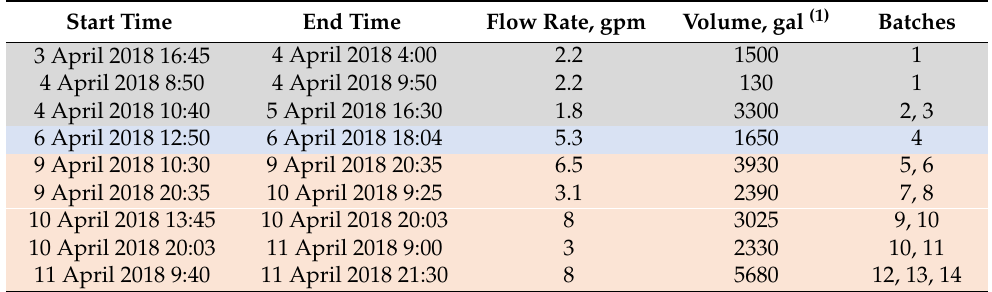
Table A8. Starting/stopping times and rates/volumes of dithionite injection into main injection flow. Different-shaded regions indicate 3 different time periods during which injection was approximately continuous for batches 1–3, batch 4, and batches 5–14, respectively.